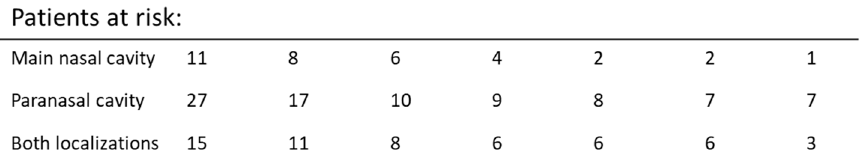
Figure 2. Five-year composite overall survival: All patients stratified according to the primary tumor site, such as the nasal cavity, paranasal sinuses and both localizations. Kaplan–Meier curves were calculated from the date of diagnosis.